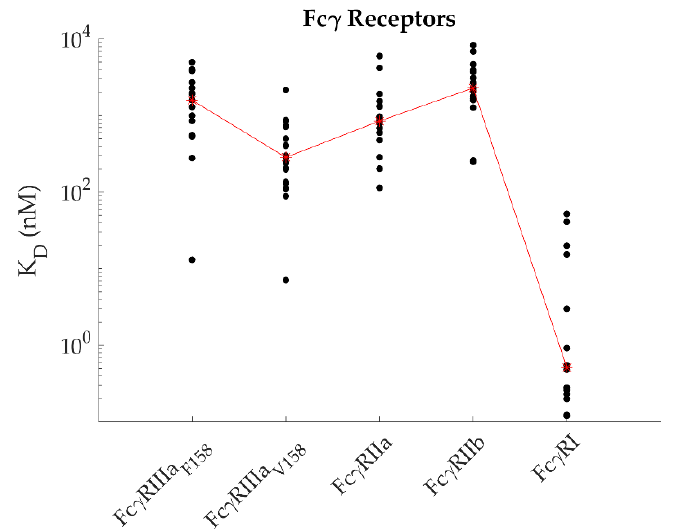
Figure 2. Affinities reported in the literature between Fc γ Rs and IgGs (35 studies). The red line crosses the median point values specific to each receptor.